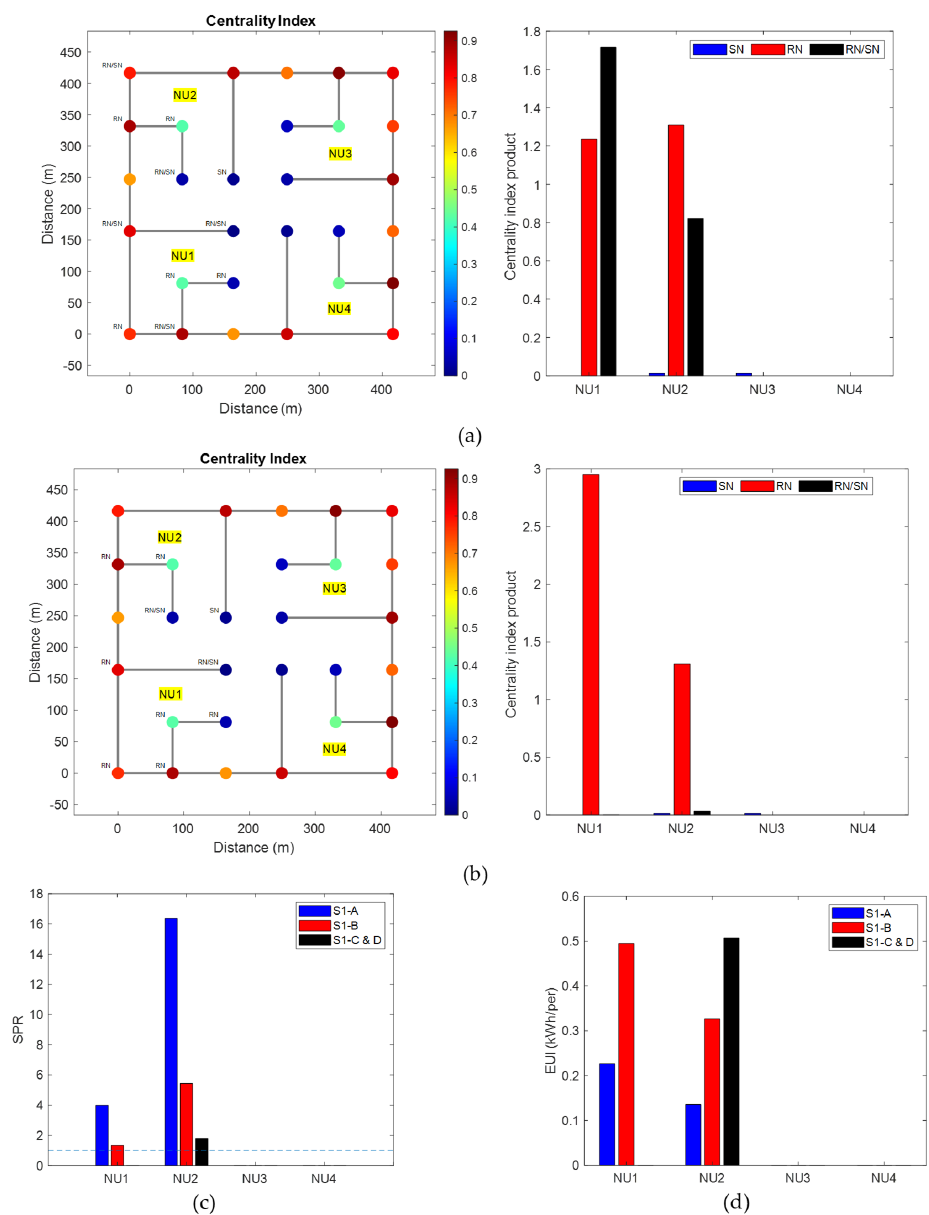
Figure 5. Centrality analysis of combination C4 ( a ) for scenarios S1 − A and S1 − B, ( b ) for scenarios S1 − C and S1 − D along with ( c ) shelter to population ratio (SPR) and ( d ) energy use index (EUI).